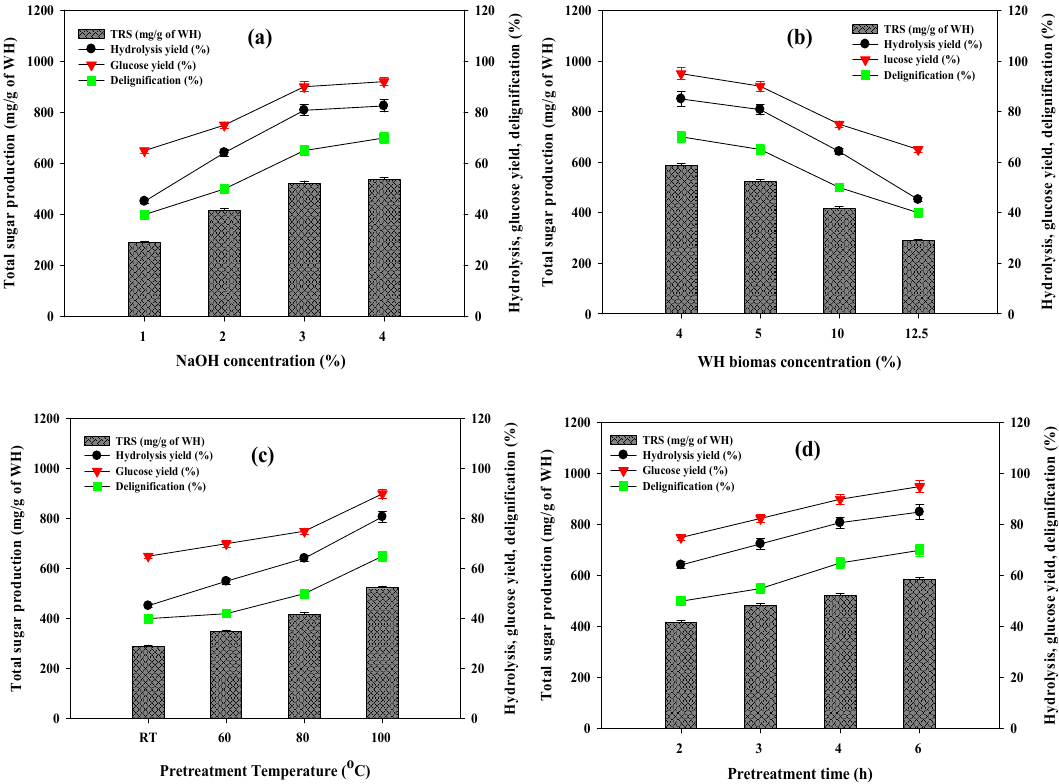
Figure 1. Effects of ( a ) different NaOH concentration, ( b ) WH biomass loading, ( c ) pretreatment temperature and ( d ) pretreatment time on delignification, total reducing sugar, hydrolysis yield, and glucose yield from WH after enzymatic hydrolysis.